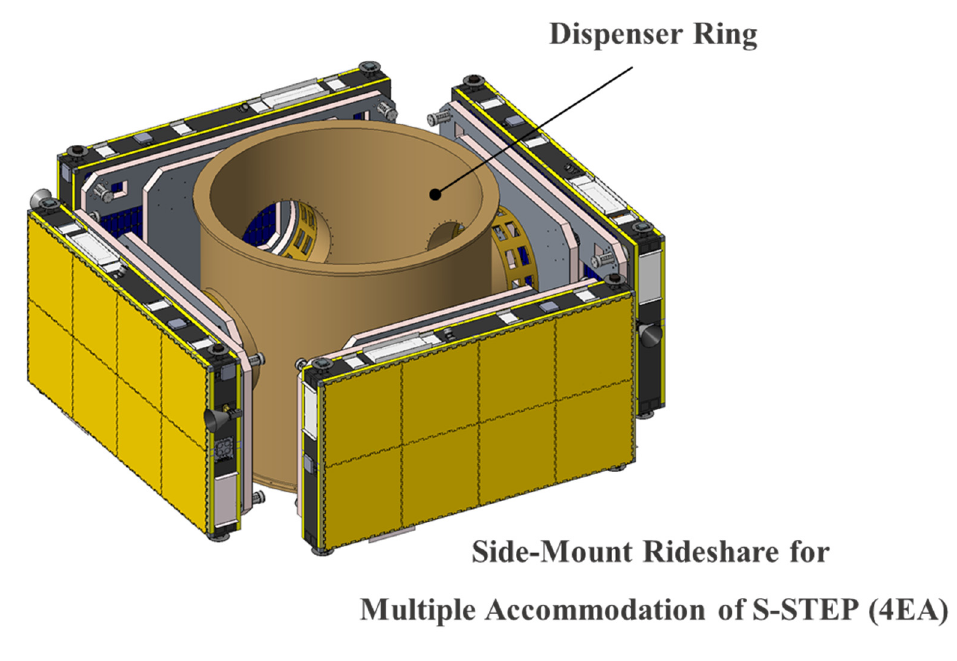
Figure 8. Side-mounting launcher-ride configuration using a dispenser ring to launch multiple satellites [( a ): OG 2 satellite, Adapted from [31], ( b ): Example of the S-STEP].